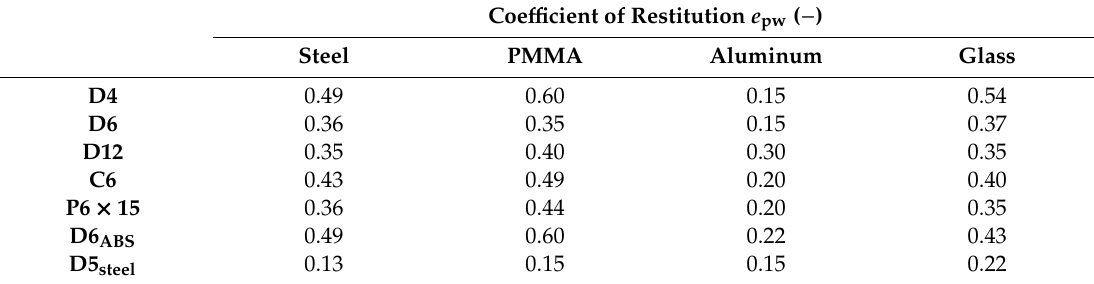
Table A6. Coe ffi cient values of contact static friction (particle-wall).